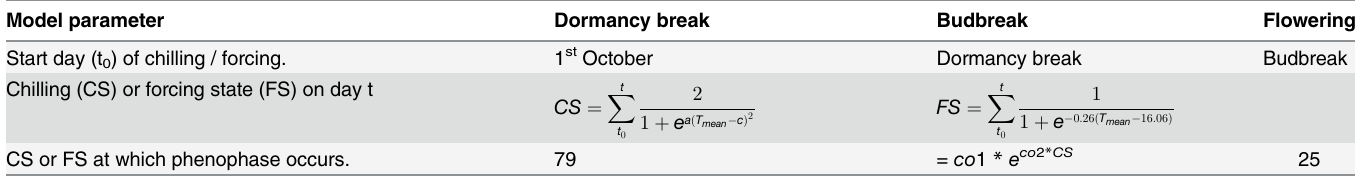
CS or FS at which phenophase